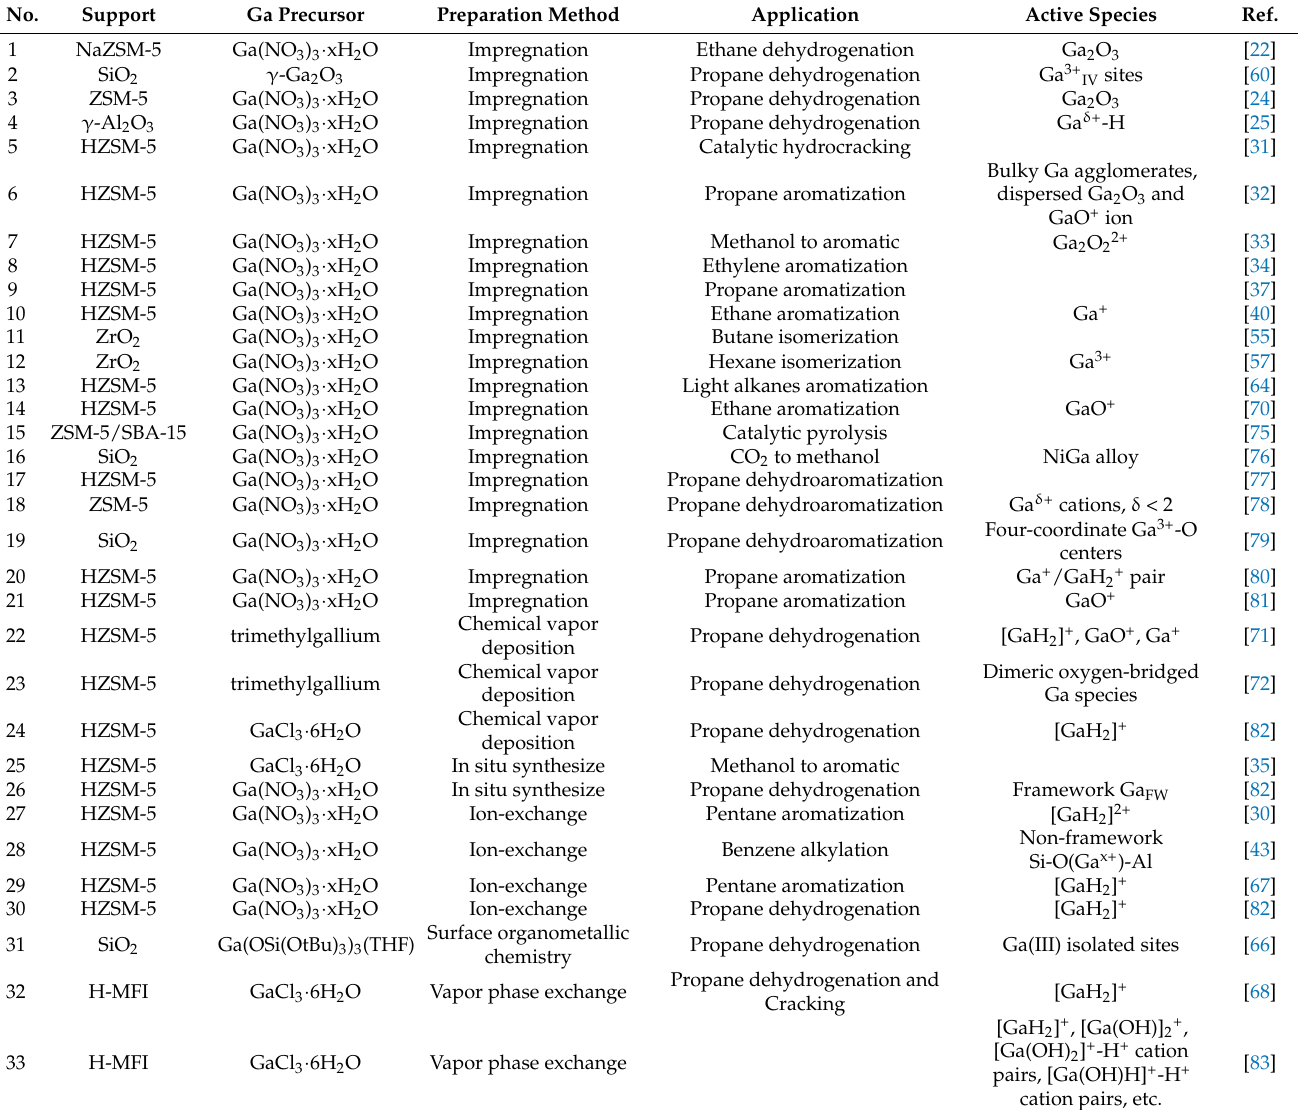
Table 1. Summary of presentative Ga-based catalysts with different preparation